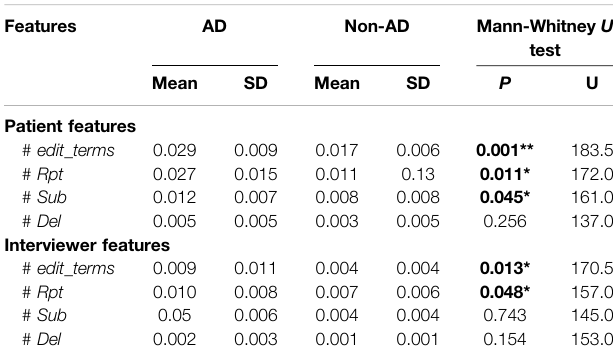
TABLE 5 | Descriptive statistics (mean, SD) and statistical signi fi cance of the dis fl uency feature set. ** denotes highly signi fi cant at p < 0 . 01; * denotes signi fi cance at p < 0 .